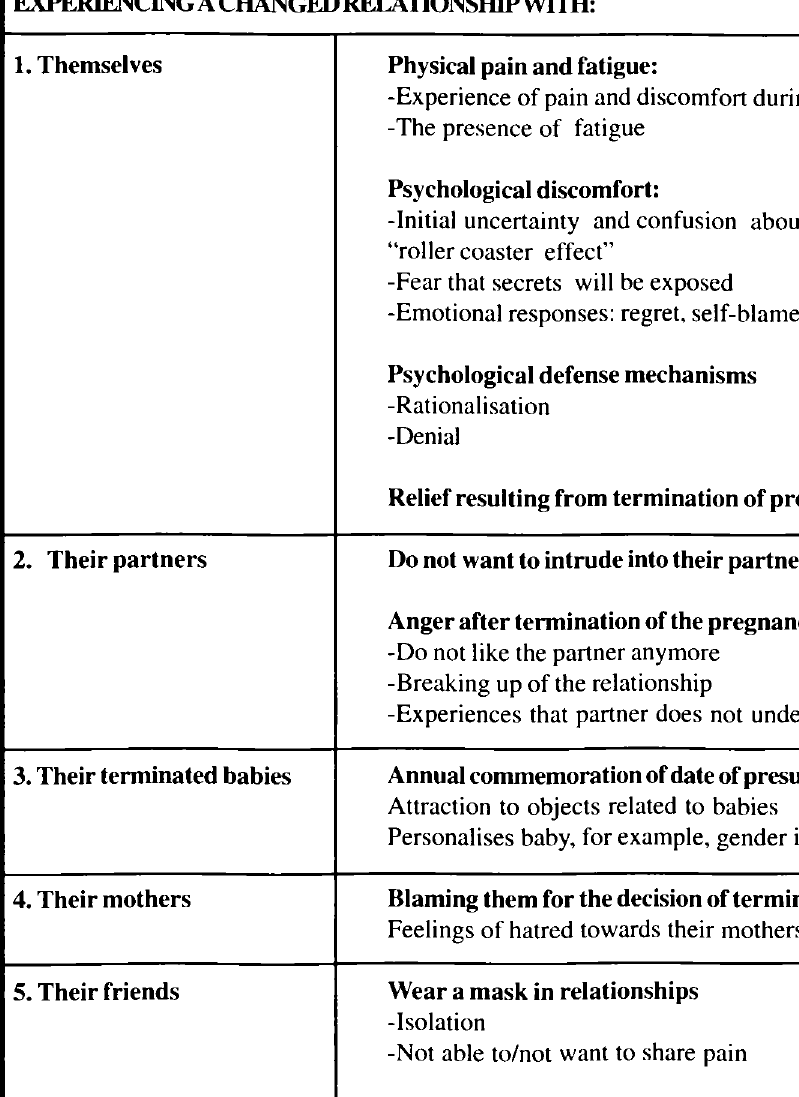
Table 1: Women’s experience of changed relationships resulting from a termination of their pregnancies EXPERIENCING A CHANGED RELATIONSHIP WITH: